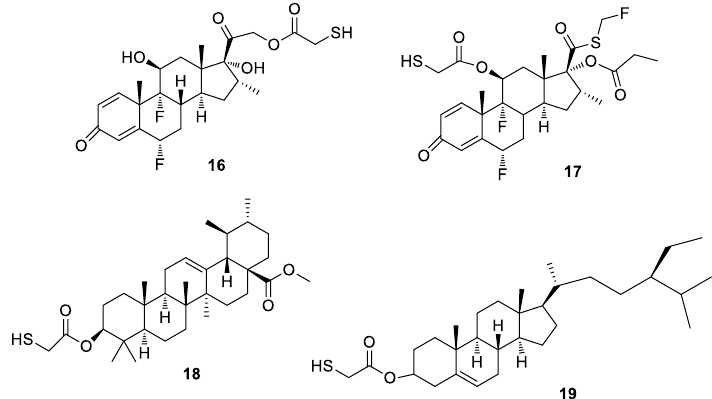
Figure 2. Structures of thiol derivatives of flumethasone ( 16 ), fluticasone propionate ( 17 ), ursolic acid methyl ester ( 18 ), and β -sitosterol ( 19